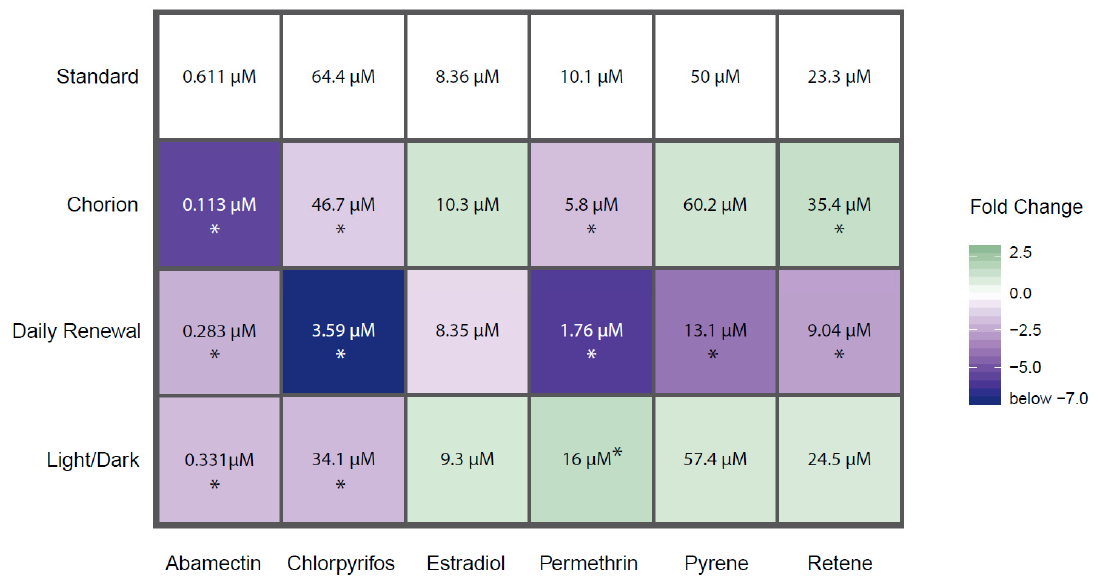
Figure 2. Heatmap of EC 50 values for each test agent–condition combination that resulted in a calculable EC 50 . Colors refer to fold change between the EC 50 derived from the varied condition vs. the standard condition. Darker colors indicate greater di ff erence in EC 50 with blue indicating increased bioactivity and green indicating decreased bioactivity. Values within cells are the EC 50 for that test agent–condition combination. * = fold change greater than 1.25 or less than − 1.25. Chemicals not shown did not produce e ff ects great enough to calculate an EC 50 under any